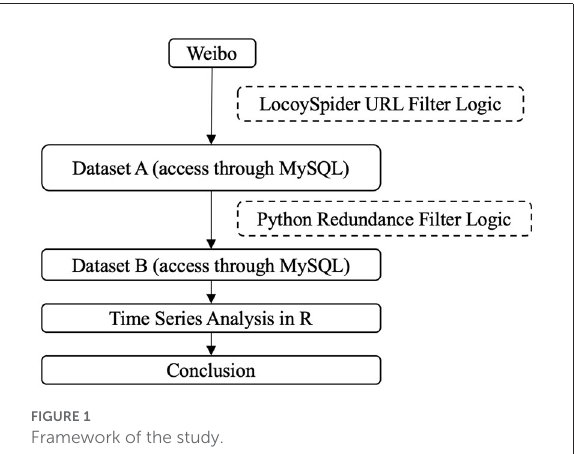
FIGURE1 Framework of the